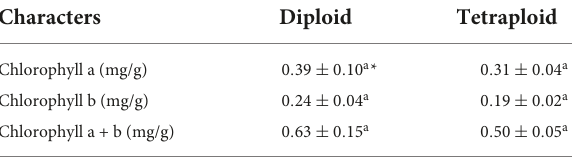
TABLE 6 Stomatal characteristics of diploid and tetraploid Anoectochilus roxburghii. Characters Diploid Tetraploid Length ( µ m)